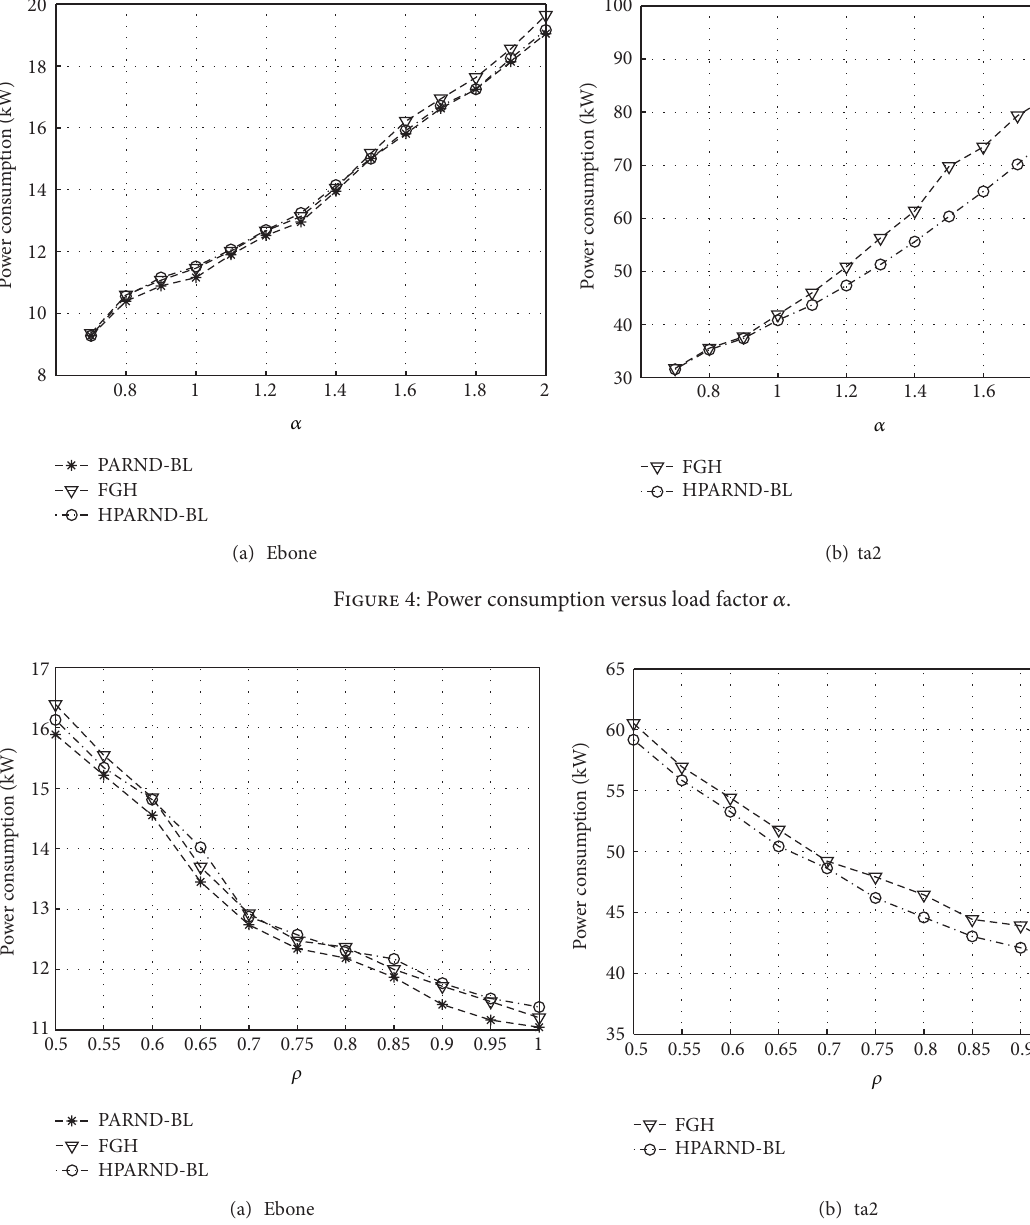
Figure 5: Power consumption versus maximum link